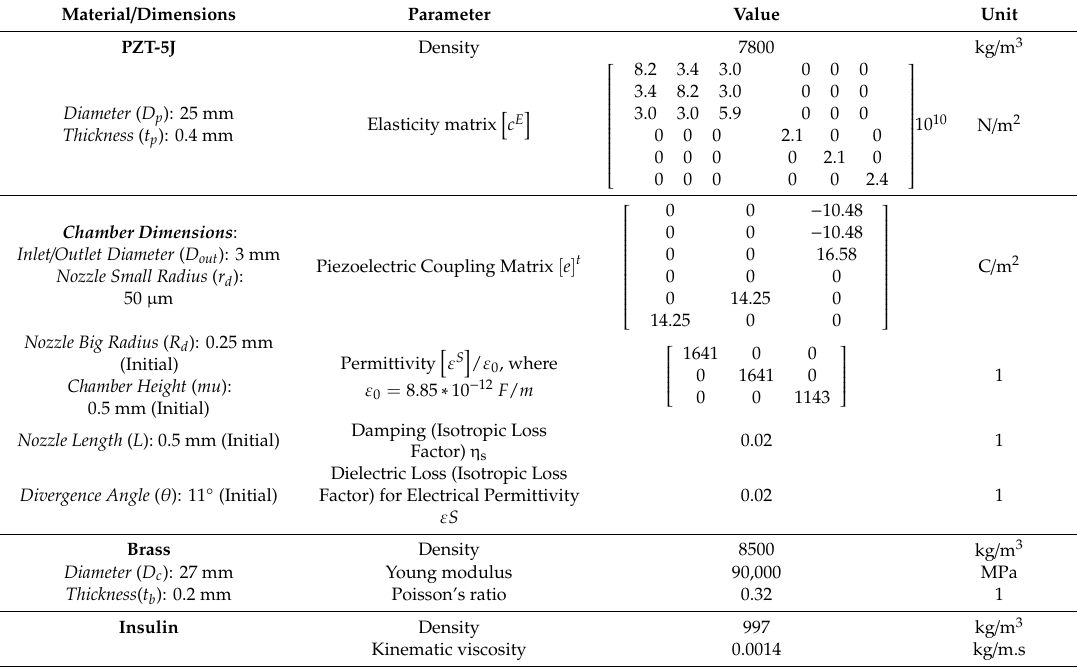
Table 1. Material properties